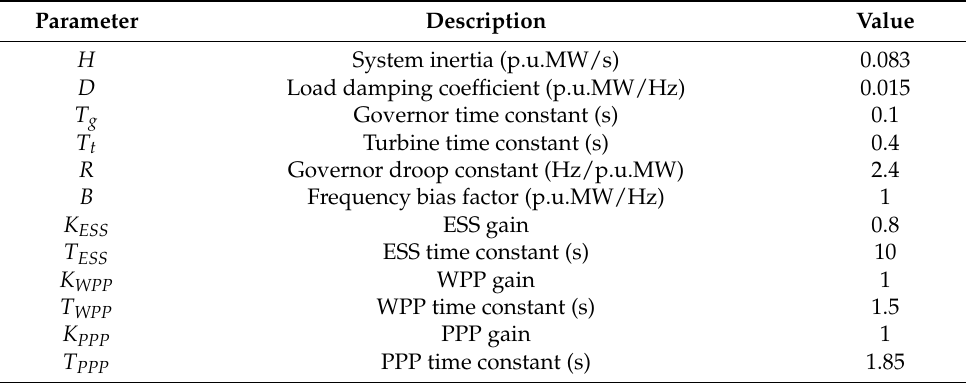
Table 1. Description and values of the MG parameters.